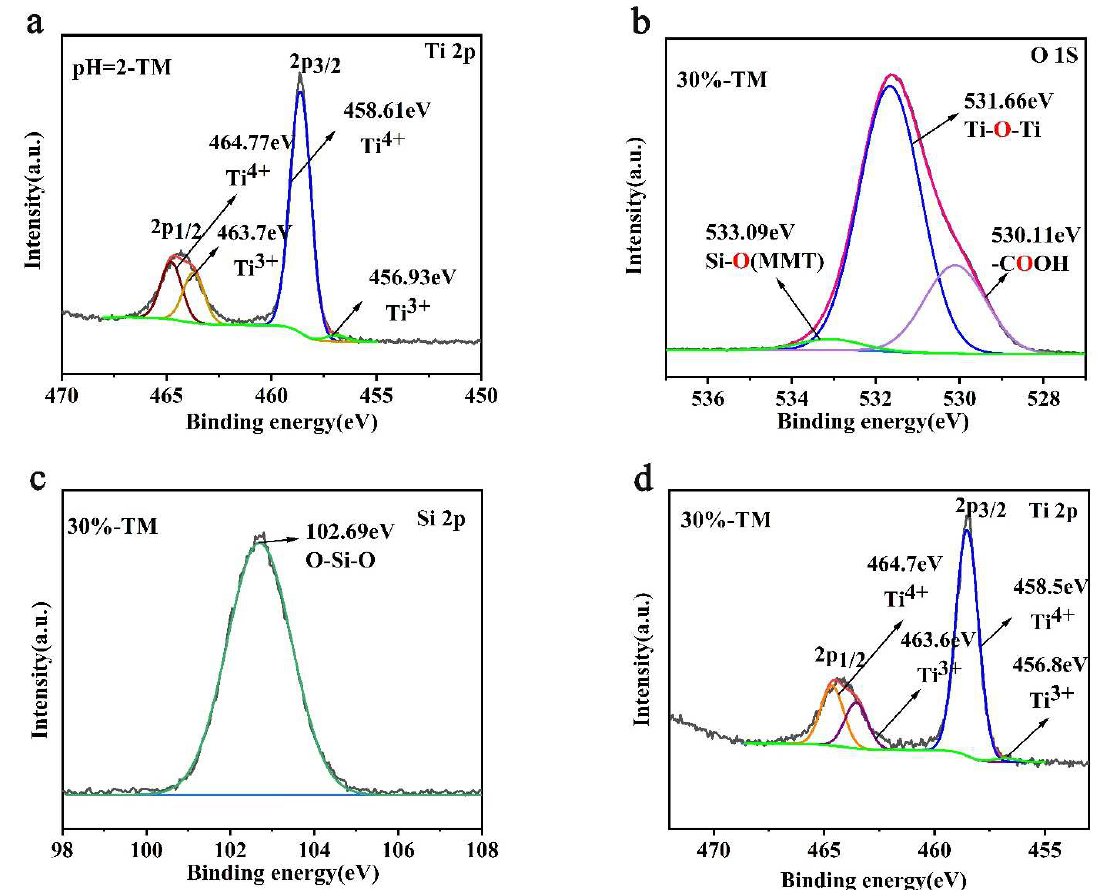
Figure 13. ( a ) XPS spectra (Ti 2p) of pH = 2-TM, and XPS spectra of 30%-TM. ( b ) O 1s; ( c ) Si 2p; ( d ) ( d ) Ti 2p Ti 2p spectra.